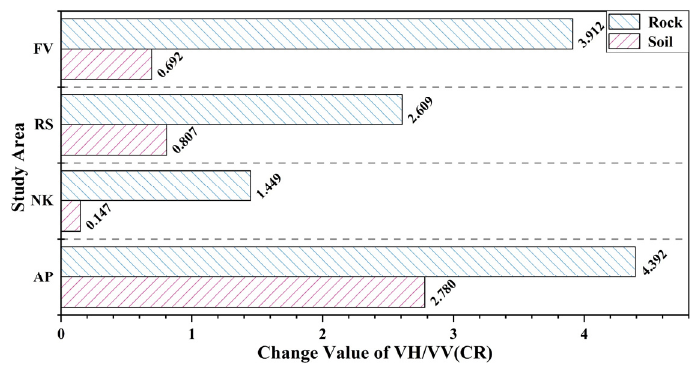
Figure 9. Comparison of monthly mean CR change values in rock and soil areas (November 2019 and February 2020).